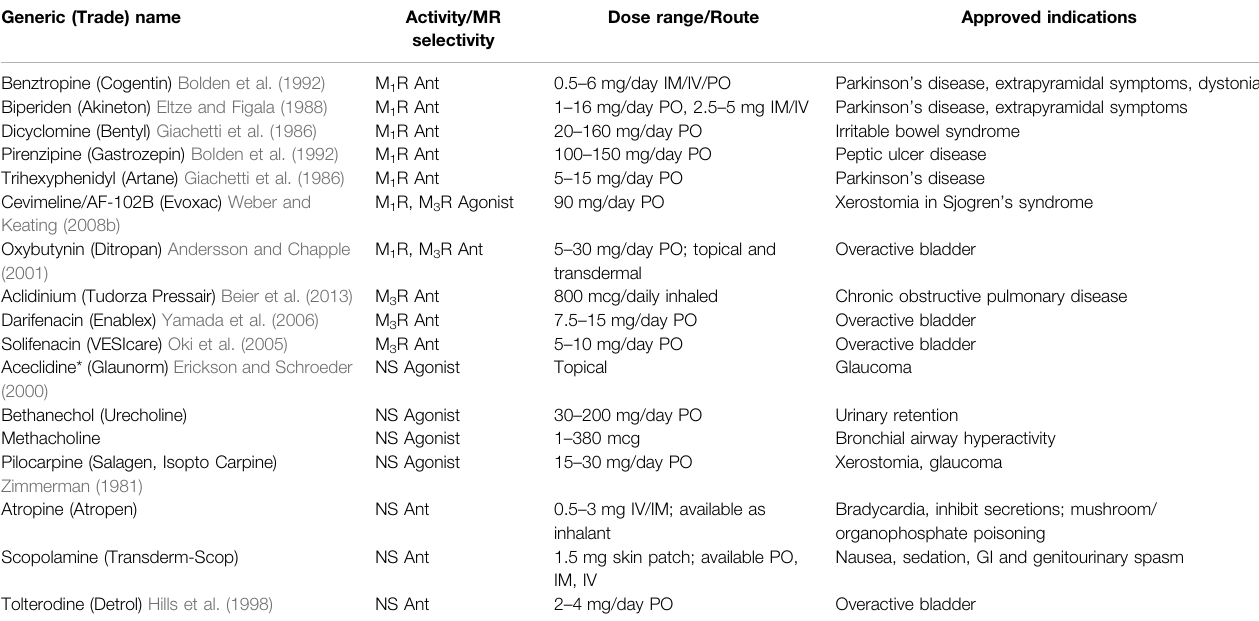
TABLE 1 | FDA/EMA approved muscarinic receptor antagonists and agonists.